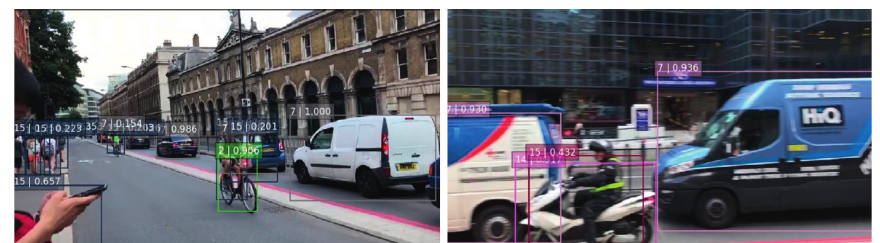
Figure 9: Test results of some normal data.